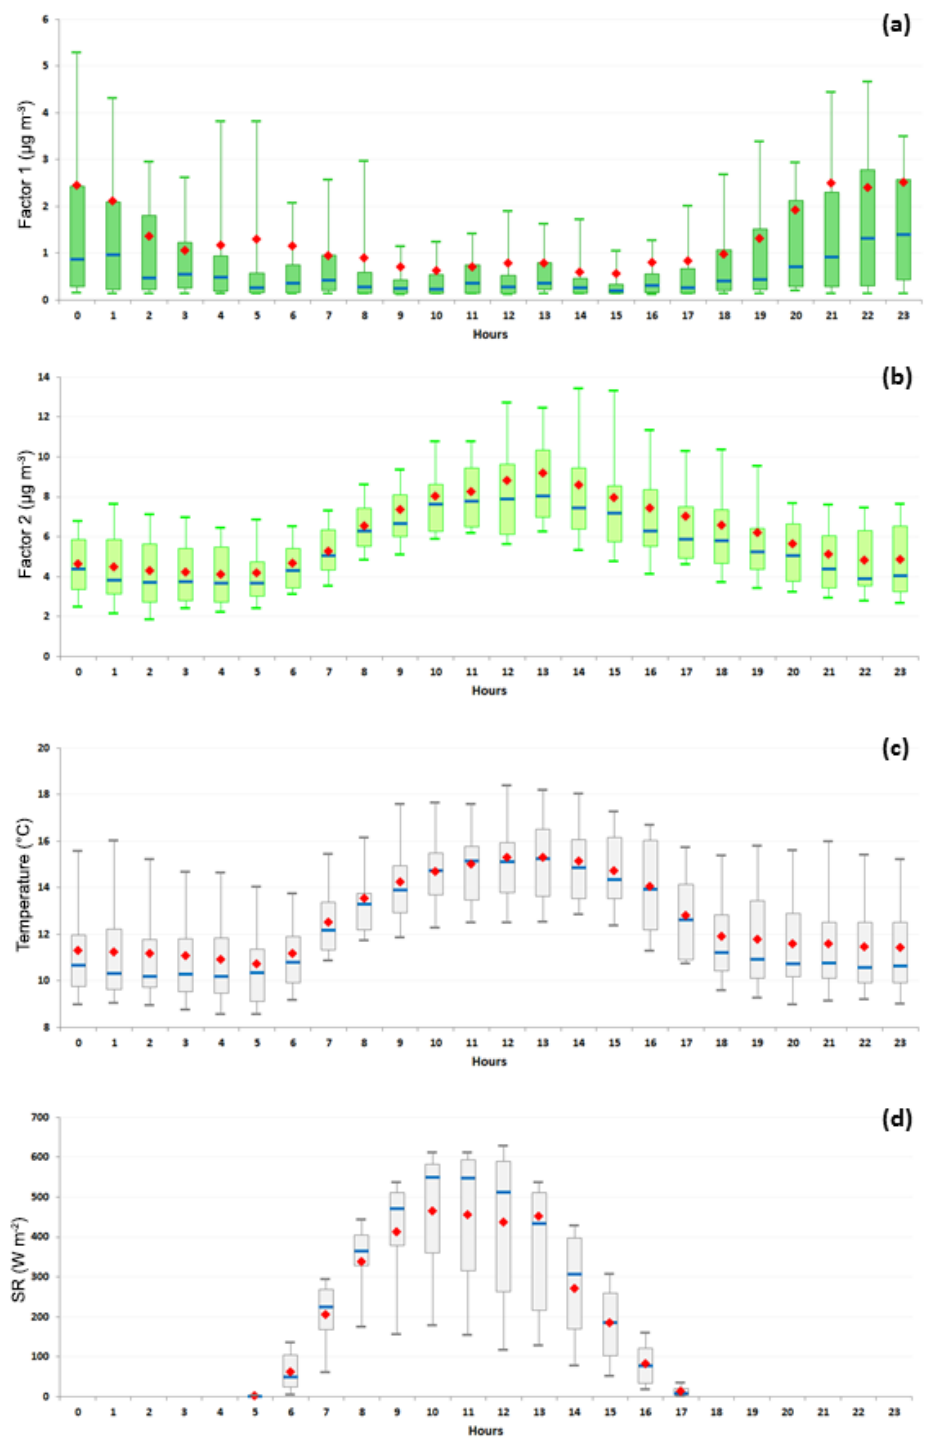
Figure 9. Diel variation in the VOC factor contribution (a, b) , temperature and solar radiation (c, d) represented by hourly box plots. Blue solid line represents the median value, the red marker represents the mean value and the box shows the interquartile range. The bottom and the top of the box depict the first and the third quartiles (i.e., Q1 and Q3). The ends of the whiskers correspond to the first and the ninth deciles (i.e., D1 and D9). Time is given as local